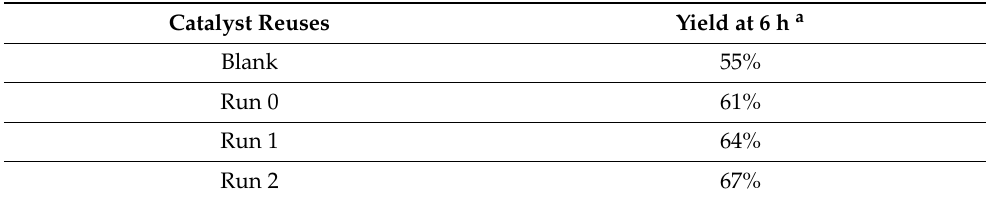
Table 3. Screening at a catalyst loading of 5%, in moles, with respect to glycerol. Catalyst